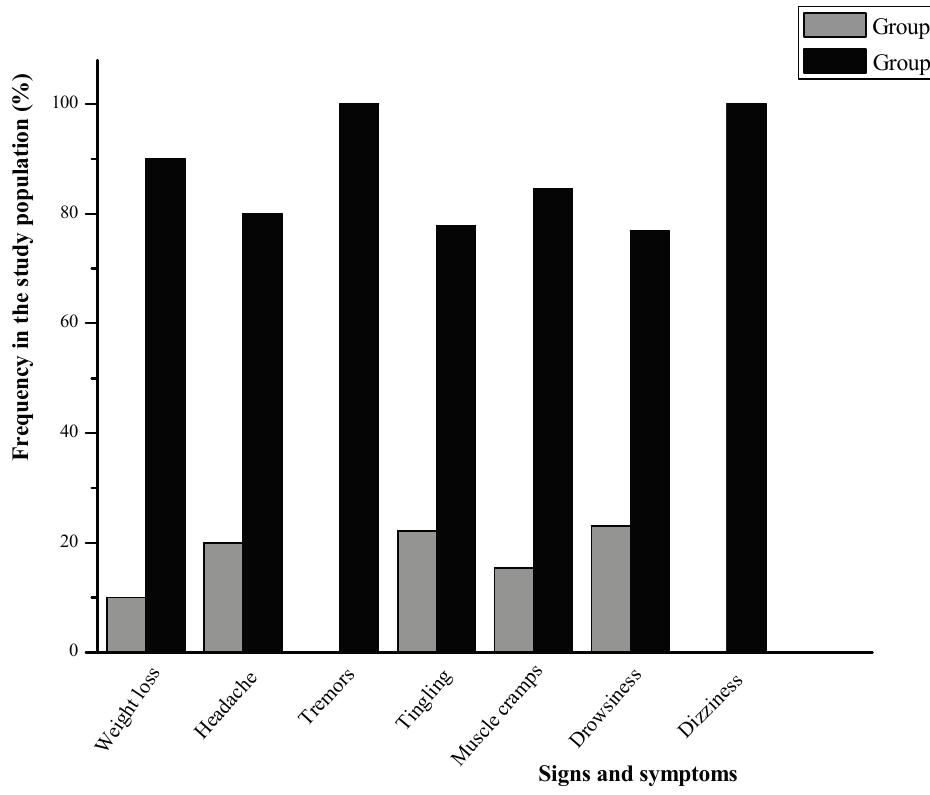
Figure 1. Comparison of somatic symptoms of BP between groups ( * SD, weight loss: ±0.15 (NCF) and ±0.33 (CF); headache: ±0.47 (NCF) and ±0.49 (CF); tremors: ±1.39 (NCF) and ±0.26 (CF); tingling: muscle cramps: ±0.28 (NCF) and ±0.47 (CF); drowsiness: ± 0.40 (NCF) and ± 0.35 (CF); dizziness: ±0.26 (NCF) and ±0.33